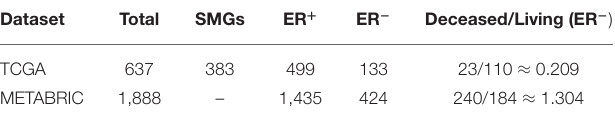
TABLE 1 | Sample numbers in two